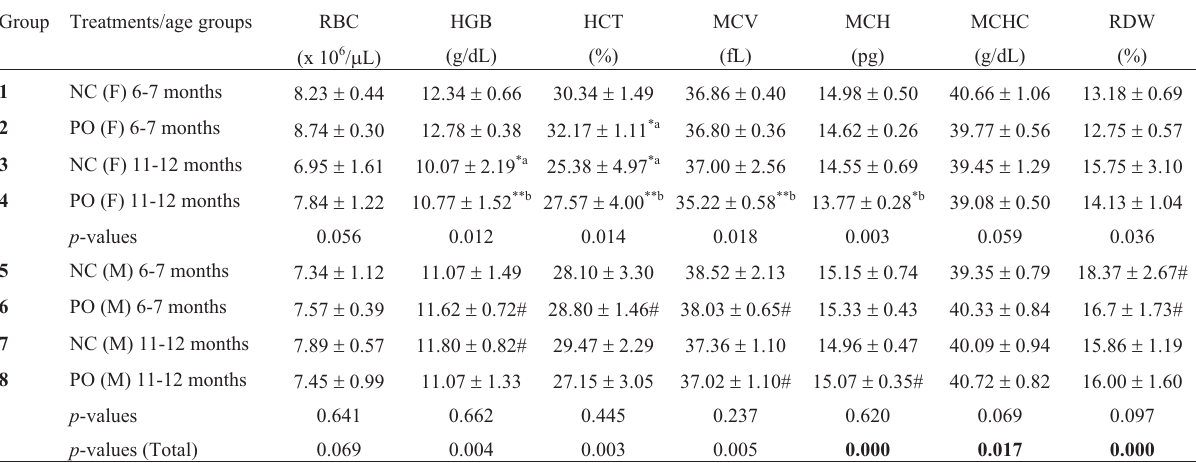
Table 3 - Results of erythrogram of elderly female (F) and male (M) Swiss albino mice after treatment with pequi oil (30 mg/animal/day) administered orally for 15 consecutive days. Negative controls (NC) received filtered water administered in the same way. Group Treatments/age